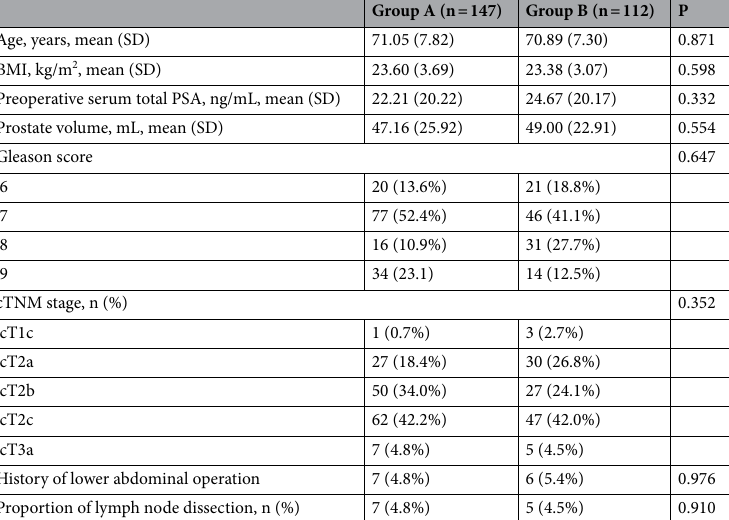
Table 1. General information. BMI body mass index, SD standard